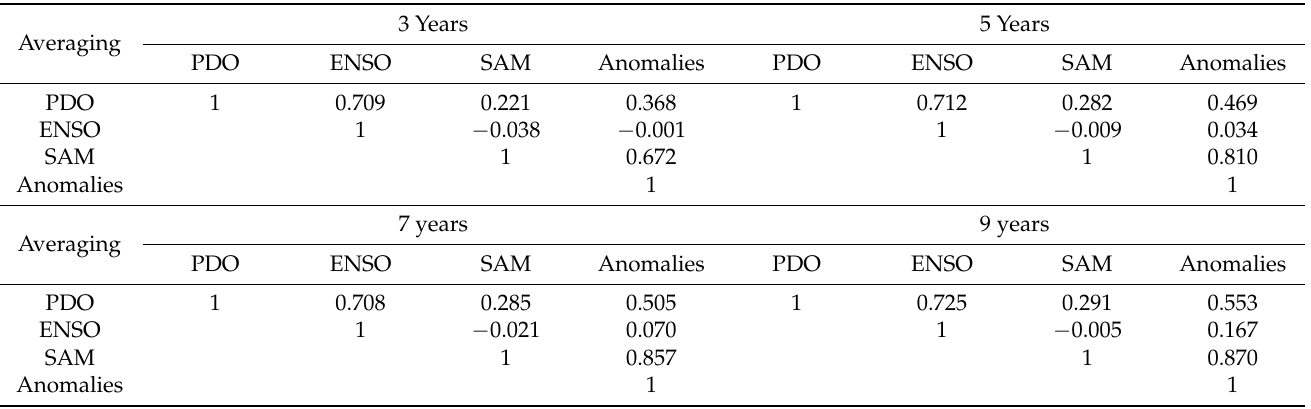
Table 1. Pearson’s coefficient of correlation (R) linking the times series of the strong wind anomalies, and the PDO, ENSO, and SAM